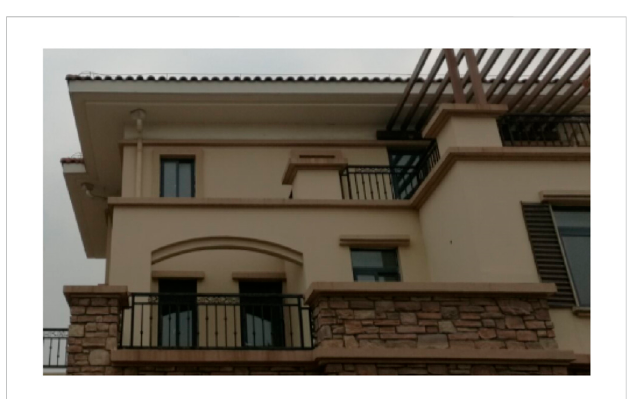
FIGURE 6 A example of open balcony.